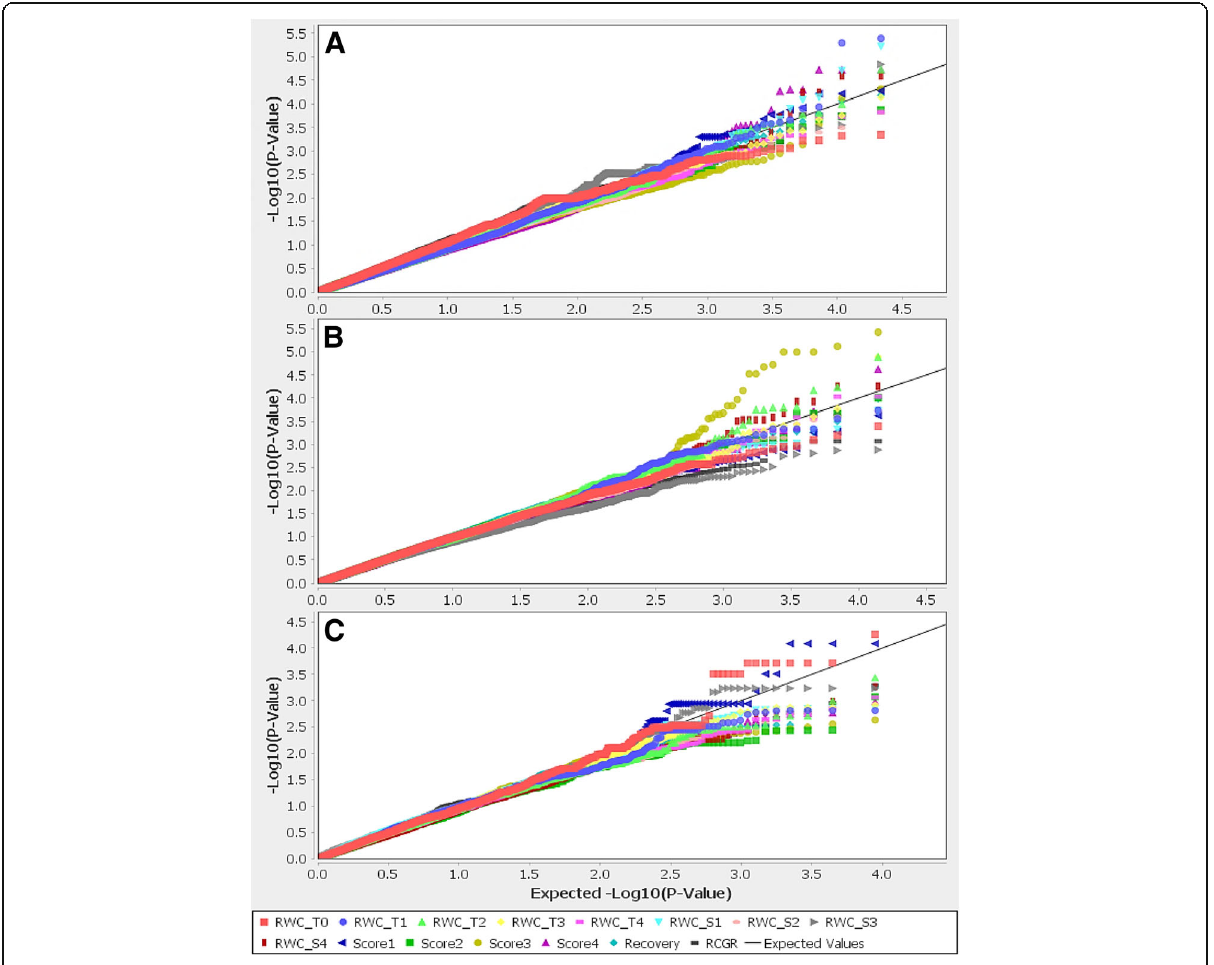
Fig. 4 Quantile-quantile plots for the full panel ( a ) and the indica ( b ) and japonica ( c ) subpanels. RWC_T0, relative water content before drought treatment; RWC_T1 to RWC_T4, relative water content after 1 to 4 weeks of drought stress; RWC_S1 to RWC_S4, slope of relative water content after 1 to 4 weeks of drought stress; Score1 to Score4, drought sensitivity score after 1 to 4 weeks of drought stress; Recovery, recovery